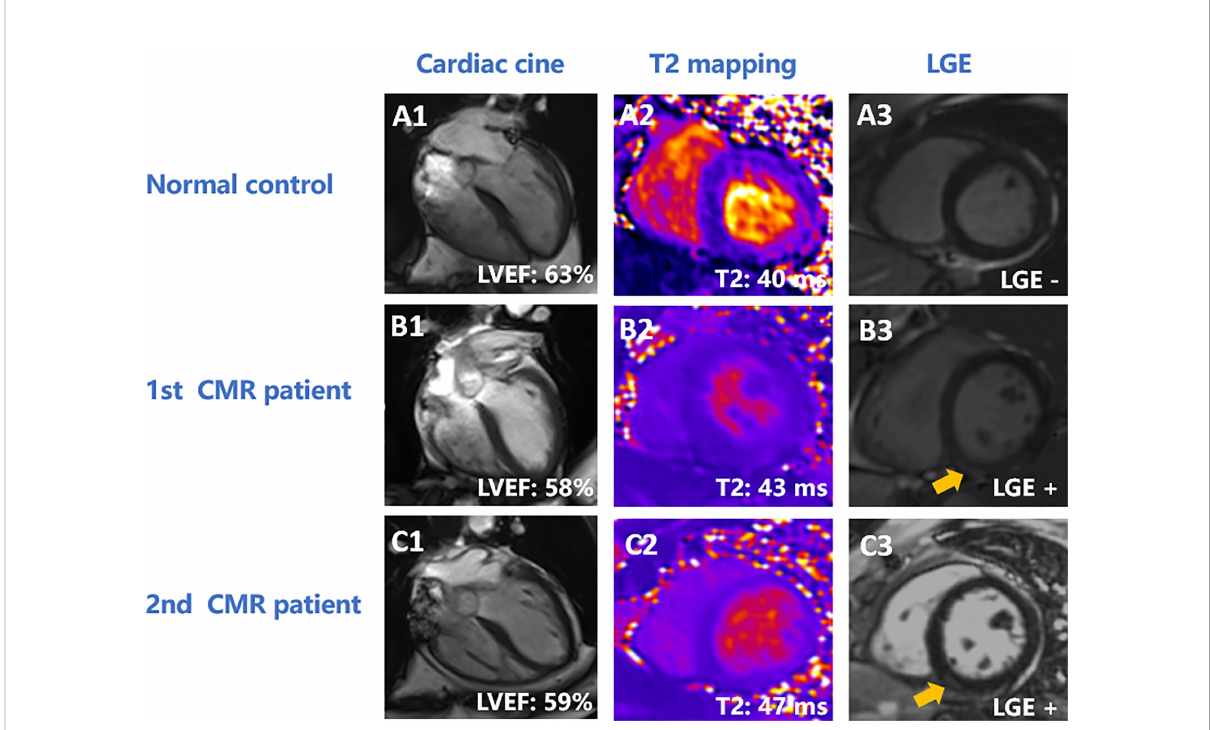
FIGURE 3 Representative CMR images of normal controls and patients. (A) A 58-year-old female healthy volunteer. LVEF was 63% (A1) , global LV myocardial T2 was 40 ms (A2) , and there was no enhancement on LGE (A3) . (B, C) A 44-year-old patient with ovarian cancer. The patient had undergone 12 cycles of paclitaxel plus platinum chemotherapy at the fi rst CMR scan. LVEF was 58% (B1) , global LV T2 value was 43 ms (B2) , and had inferior enhancement (yellow arrow) on LGE (B3) . At 11-month follow-up, the patient had completed 15 cycles of paclitaxel plus platinum chemotherapy. LVEF was 59% (C1) , global LV myocardial T2 value was 47 ms (C2) , and had inferior enhancement (yellow arrow) (C3) . LVEF, left ventricular eject fraction; LGE, late gadolinium